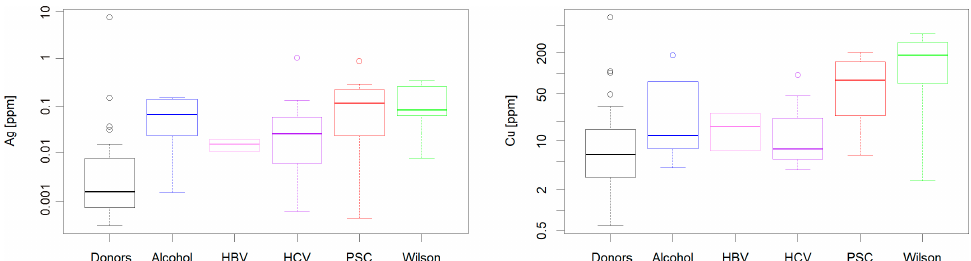
Figure 2. Ag and Cu levels in recipients subdivided with respect to the disease type, compared with the donors. For Ag, individual disease types differ significantly from recipients, but do not differ among themselves. For copper, Primary Sclerosing Cholangitis (PSC) and Wilson’s disease (WD) differ significantly from both other recipients and donors. The circles represent outliers according to Grubb’s test. The corresponding data for Fe and Zn are given in Figure S1. The results of post hoc Dunn test are provided in Table S3.